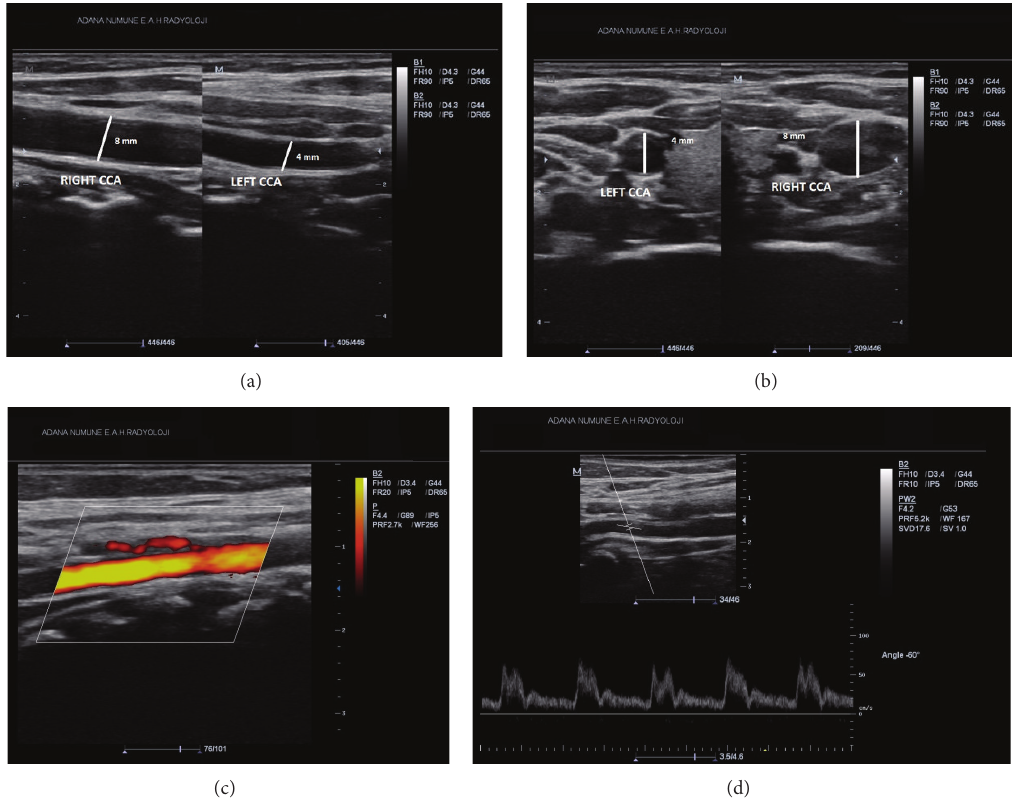
Figure 1: (a) Doppler US images demonstrate the diameters of the right and left CCA, which are 8mm and 4 mm, in respect. (b) These axial Doppler US images reveal the diameters of the right and left ICA. (c) The Doppler view of the left ECA and its branching. (d) The spectral drawing demonstrating that the vessel mentioned in Figure 1(c) is indeed the ECA.